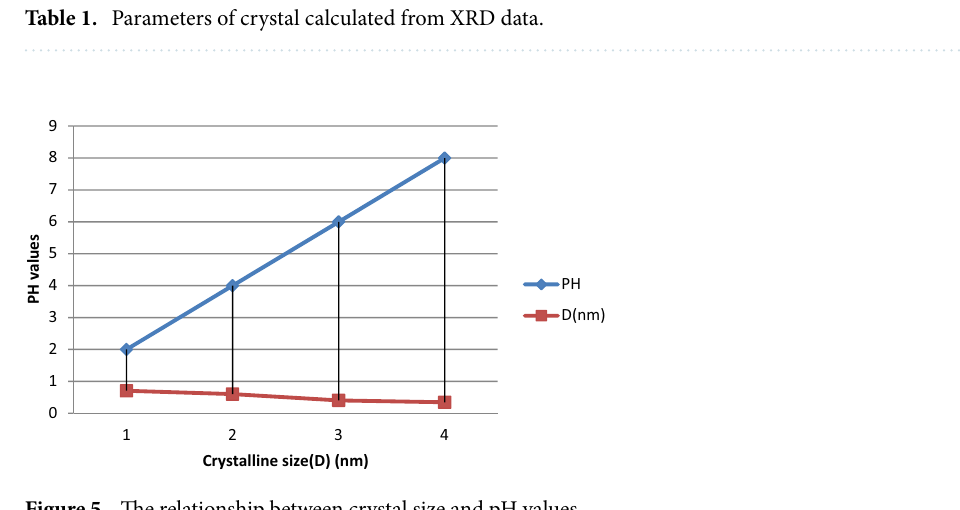
Figure 5. The relationship between crystal size and pH values.